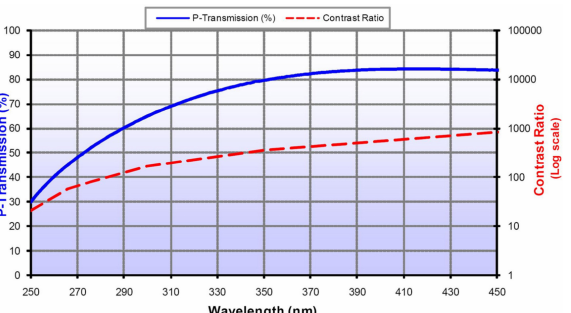
Figure 6. Polarization characteristic curve of wire grid polarizer (the wire grid polarizer type is 68-751, this figure is from EDMUND OPTICS Company).